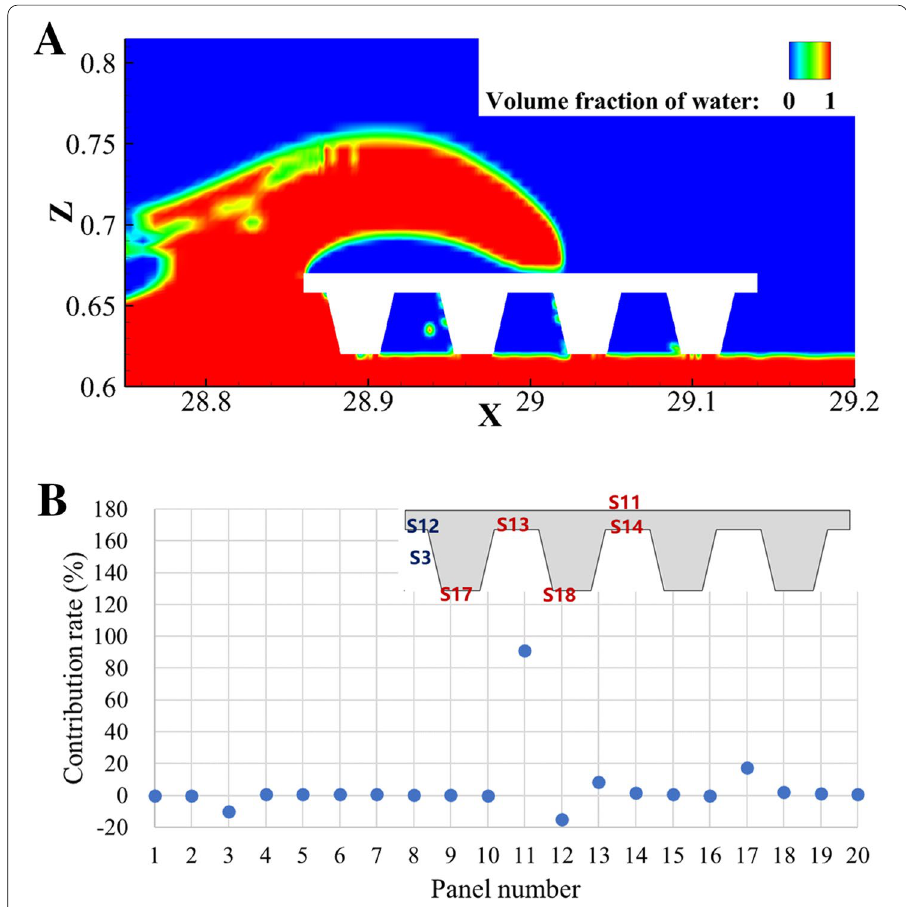
Fig. 19 Phase contour ( a ) and the contribution rate of each panel to the horizontal force at t